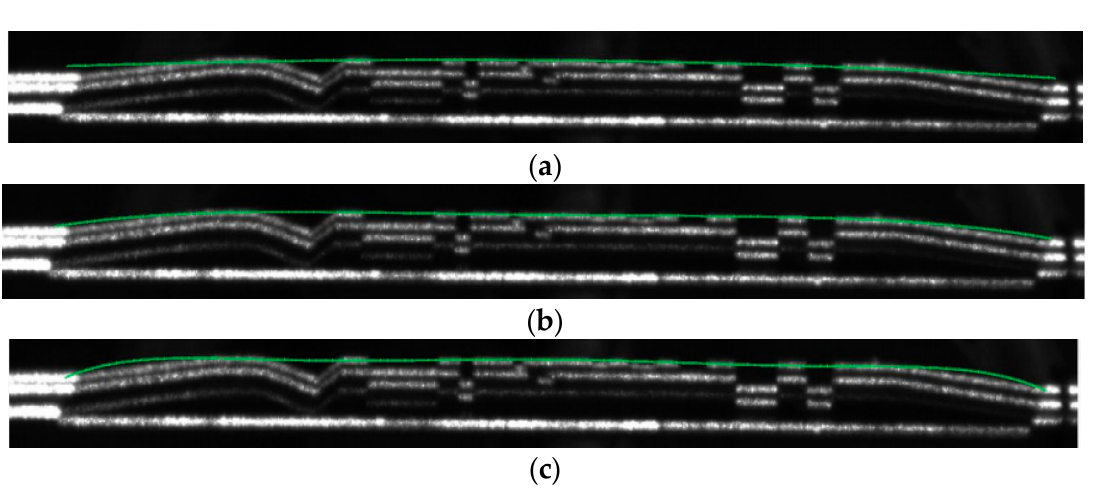
Figure 12. Fitted line estimation results for the ( a ) first line and ( b ) second line.